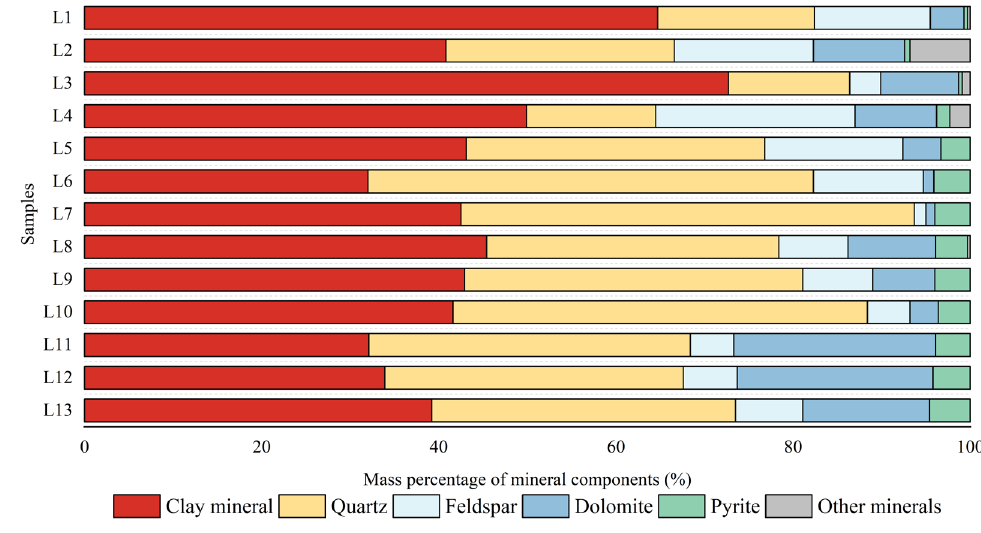
Figure 3. The proportions of mineral composition.